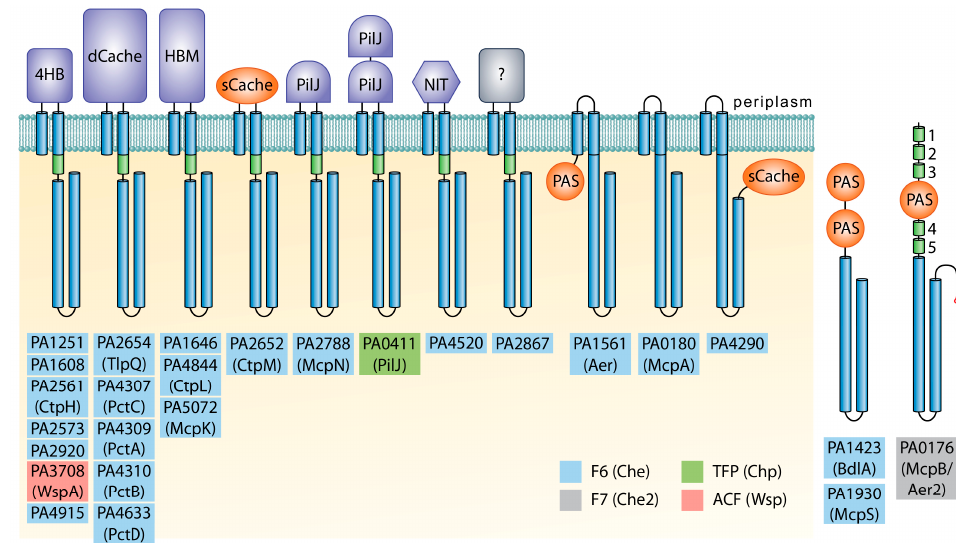
Figure 2. The chemoreceptor repertoire of P. aeruginosa PAO1. Ligand binding domains with parallel helix or α / β folds are shown in purple and orange, respectively. HAMP (histidine kinases, adenyl